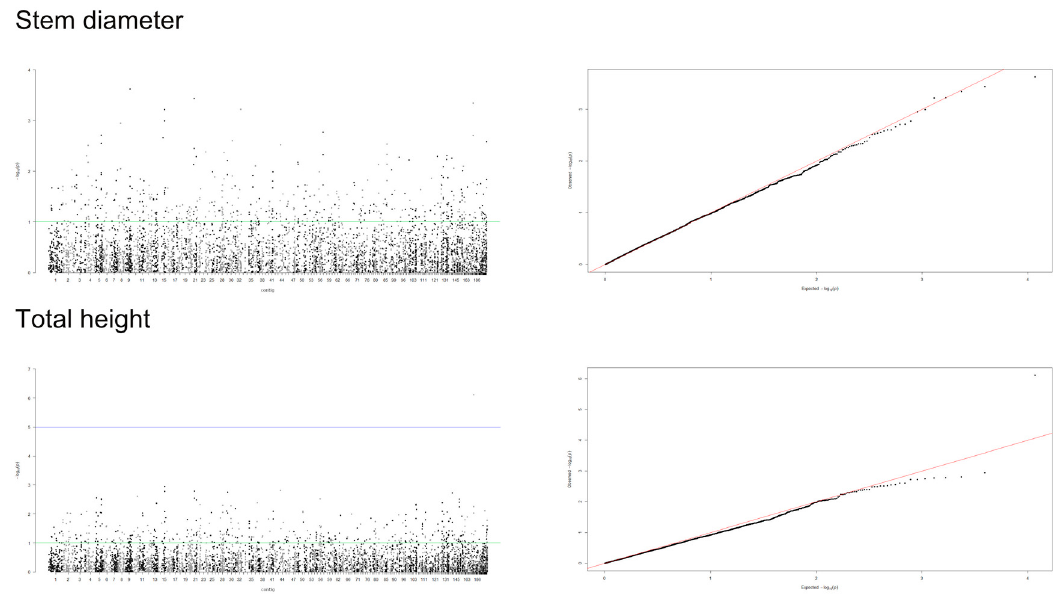
Figure 4. Manhattan and Q-Q plots for genome-wide association of S. platyclados growth traits (before thinning) with Single Nucleotide Polymorphism (SNP) markers of Q + K model. The quantile-quantile plot indicates the fitness between expected (red lines) and observed p -values (black